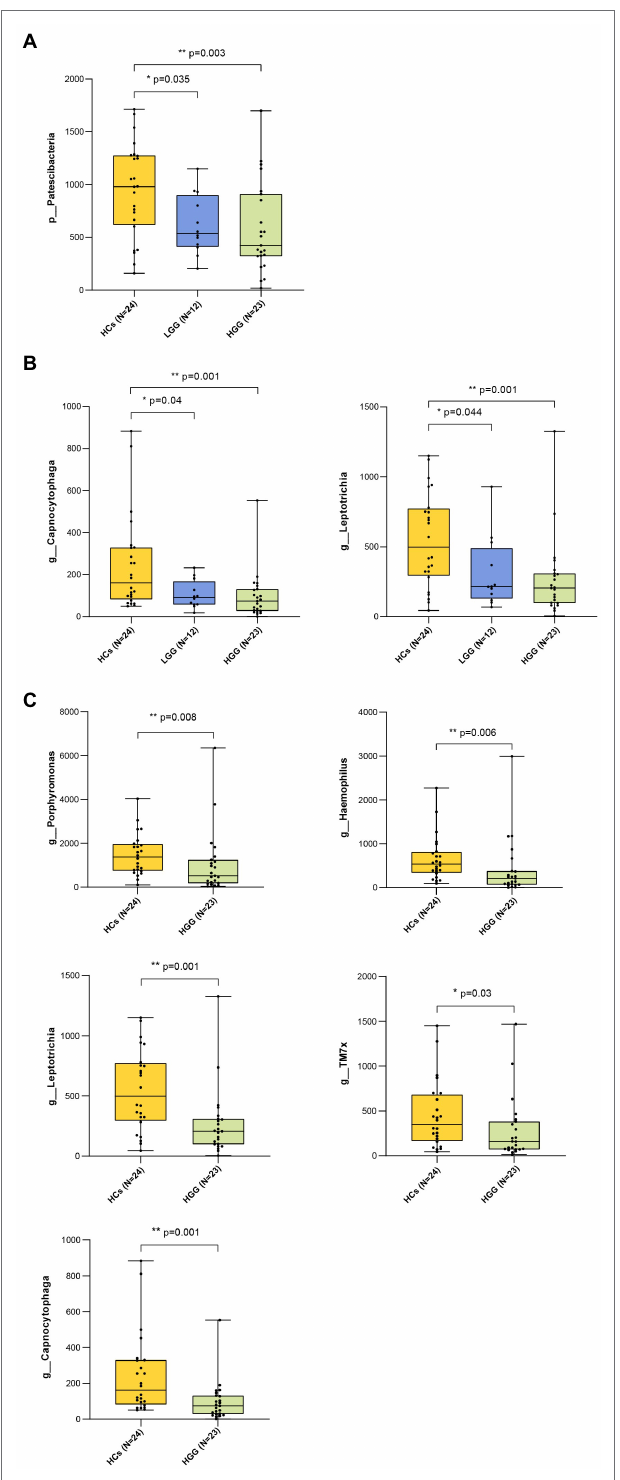
FIGURE 3 | Bacteria taxonomic profiling of oral microbiome from healthy controls and glioma patients. (A) Relative abundance of the pylum Patescibacteria in HCs, LGG, and HGG; (B) relative abundance of genera Capnocytophaga and Leptotrichia in HCs, LGG, and HGG;